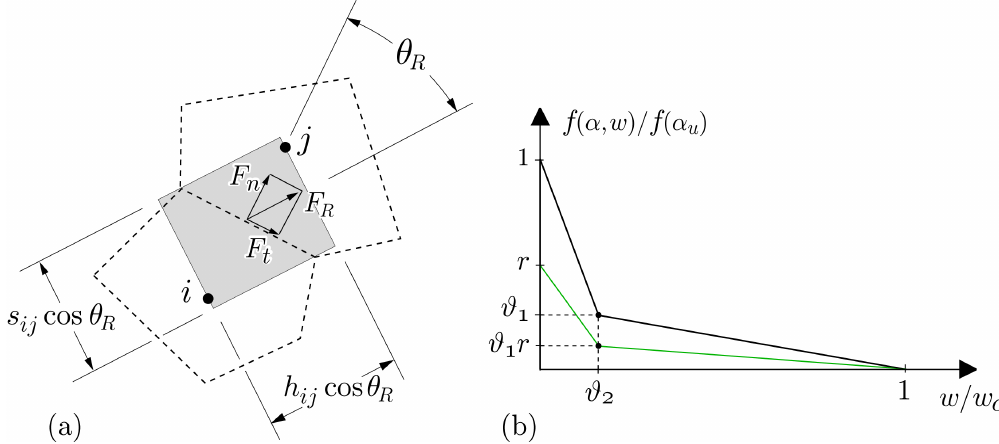
Figure 4. ( a ) Determination of tensile stress for planar analyses; and ( b ) tension softening relation. Parameters ϑ 1 and ϑ 2 define the break point of the softening diagram in terms of tensile strength f ( α u ) and traction-free crack opening w c ,